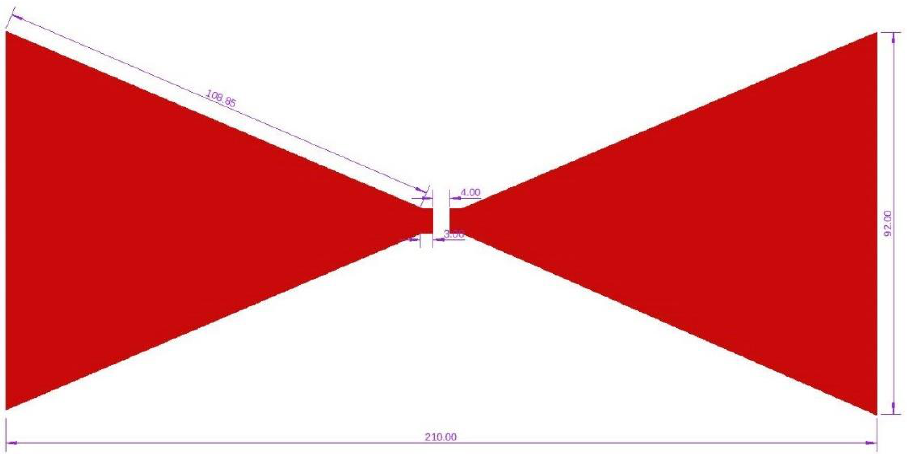
Figure 1. Bowtie antenna design with dimensions in mm.